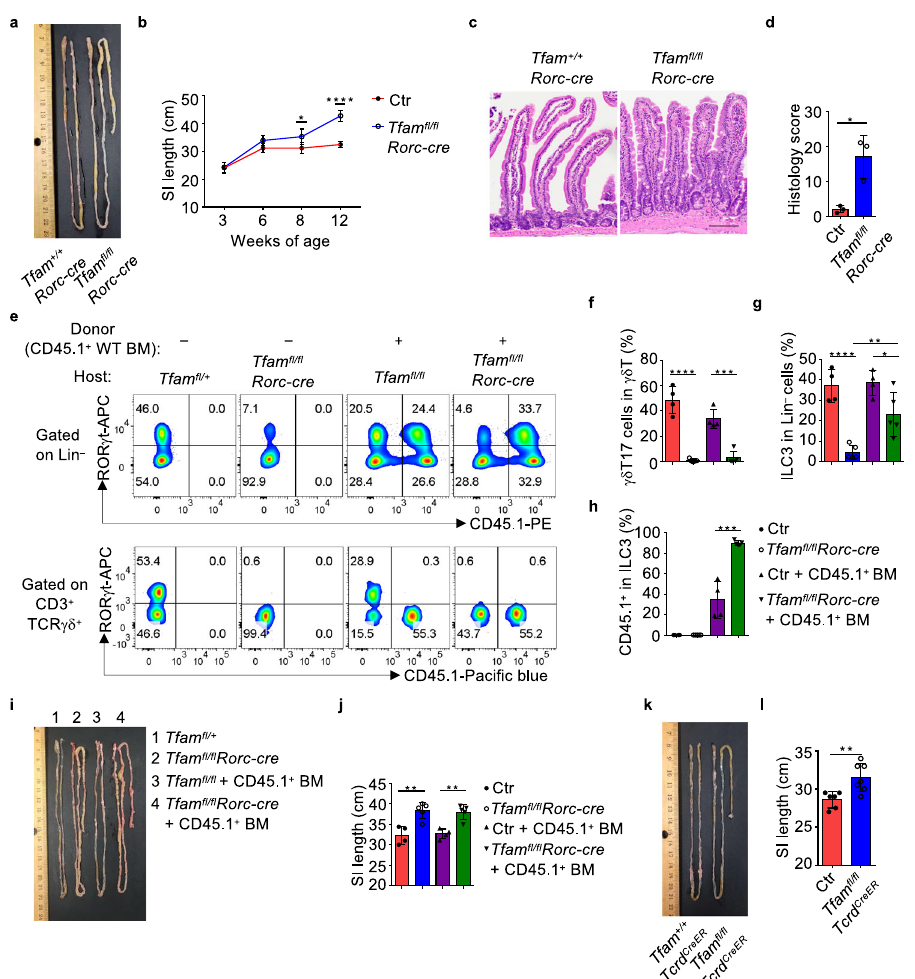
Fig. 3 Tfam de fi ciency in γδ T17 cells cause small intestine lengthening. a Picture of the small intestine of 8-week-old littermate Tfam + / + Rorc-cre and Tfam fl / fl Rorc-cre mice. Representative data of three independent experiments. b Small intestine length of mice with indicated genotypes at different ages (week 3, P = 0.8542; week 6, P = 0.056; week 8, * P = 0.03853; week 12, **** P < 0.0001). Ctr, n = 5 for 3-week-old and 12-week-old age, n = 4 for 6-week-old age, n = 3 for 8-week-old age, Tfam fl / fl Rorc-cre , n = 4. Compiled data from three independent experiments. c Hematoxylin and eosin (H&E) staining of the small intestine from 12-week-old mice with indicated genotypes. Representative data of two independent experiments. Scale bar, 100 µ m. d Histology score of the small intestine ( n = 3 for each group) (* P = 0.0135). Each dot represented the data from an individual mouse. Compiled data from one experiment. e ROR γ